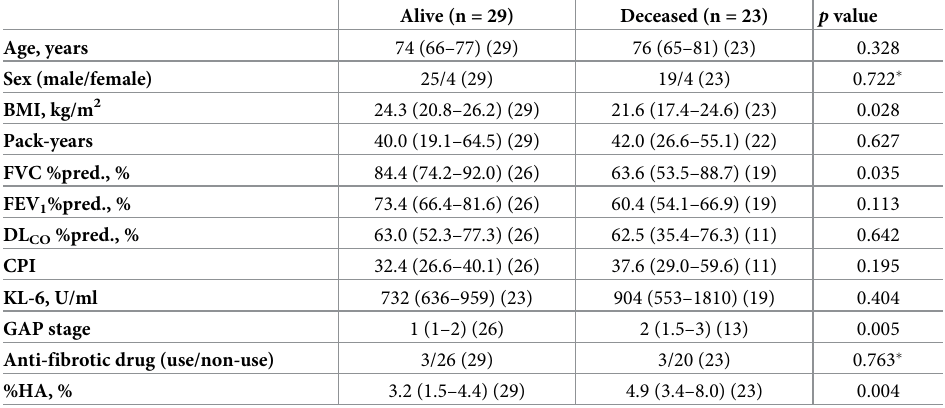
Table 3. Comparison of clinical features between alive and deceased